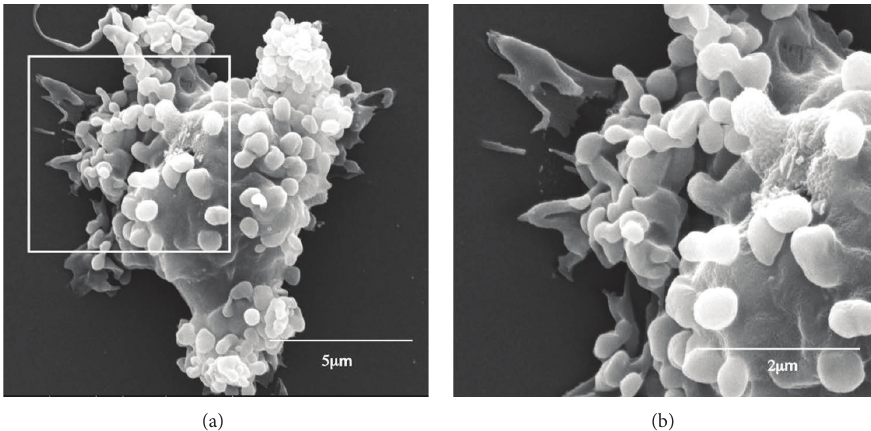
Figure 3: Scanning electron microscopy of anti-Gal coated 𝛼 -gal nanoparticles binding to macrophages via Fc/Fc 𝛾 R interaction. 𝛼 -gal nanoparticles coated with anti-Gal Ab were coincubated with adherent GT-KO pig macrophages for 2 hours at room temperature, washed to remove nonadherent nanoparticles, and processed for electron microscopy analysis. Many 𝛼 -gal nanoparticles adhere to the surface of a representative macrophage. The inset in (a) is enlarged in (b). Modified from